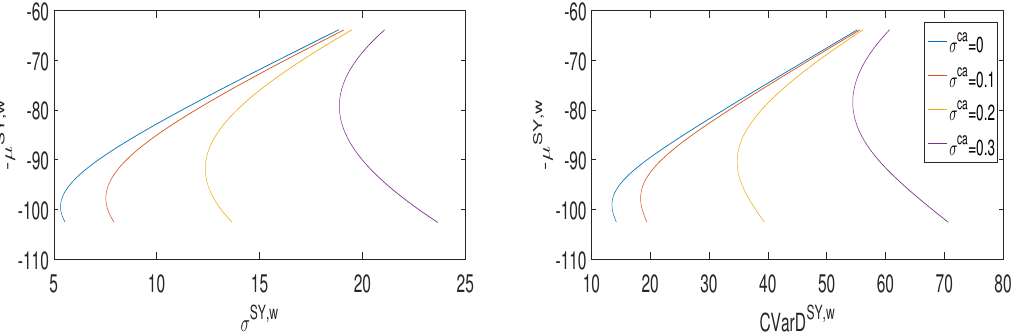
Figure 1. System portfolio frontiers for the fully dispatchable case. Each graph plots 4 system portfolio frontiers (for σ ca = 0, 0.1, 0.2, 0.3). Left panel: The ( − µ SY,w , σ SY,w ) plane. Right panel: The ( − µ SY,w ,CVaRD SY,w ) plane. The σ ca = 0 case is the leftmost curve.